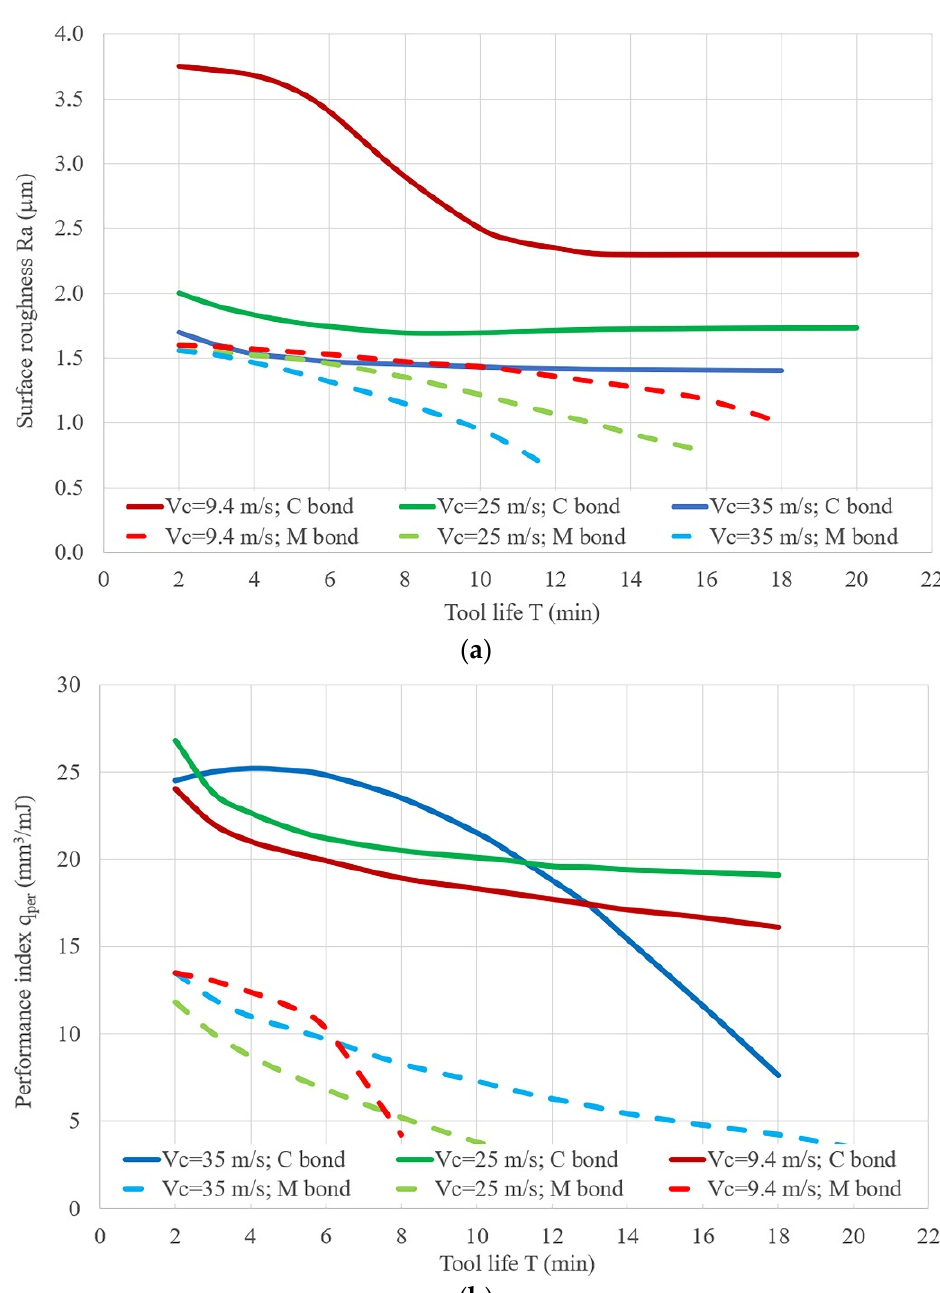
Figure 2. The dependence of the reduced cutting ability ( a ) and the roughness of the machinable surface ( b ) on the cutting speed during belt grinding: v c = 35 m/s; v c = 25 m/s; v c = 9.4 m/s; for the belt on a C synthetic bond and on an M natural bond: workpiece material: steel 45; workpiece speed v w = 0.058 m/s; vertical oscillation frequency w os = 200 mm − 1 ; the value of the vertical oscillation Aos = 3 mm; grit = F60.